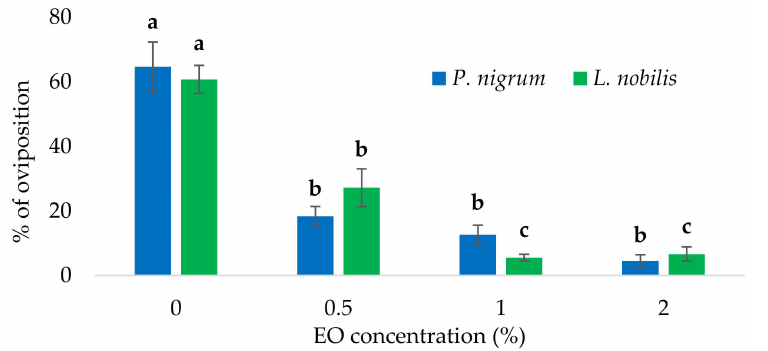
Figure 6. Protective effect of different concentrations of the Laurus nobilis and Piper nigrum essential oils (EOs) against the oviposition of the blowfly Calliphora vomitoria on beef meat. For each EO, different letters (a–c) indicate significant differences among concentrations (Tukey’s HSD, p ≤